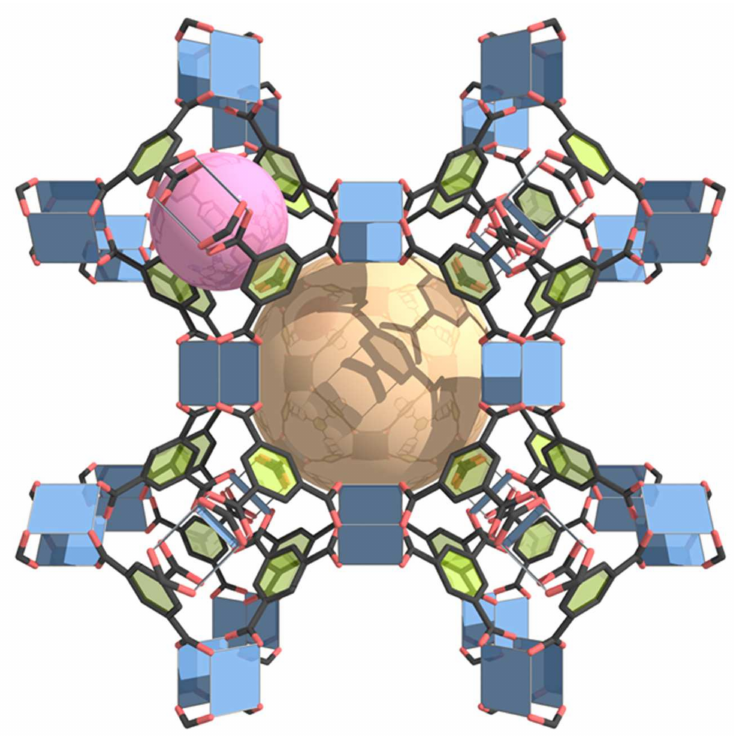
Figure 3. Crystal structure of the desolvated HKUST-1 (Cu 3 (BTC) 2 ) MOF. The blue polyhedra represent the Cu paddlewheel SBU structure. (red: oxygen, and black: